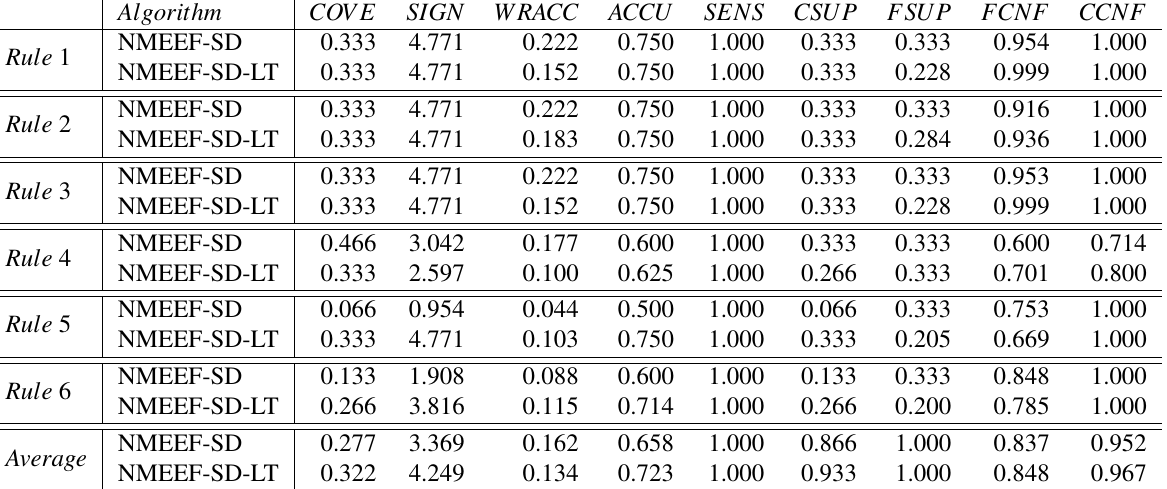
Table 6. Results for the simple NMEEF-SD algorithm and with genetic lateral tuning for the rules extracted in the data set Iris .